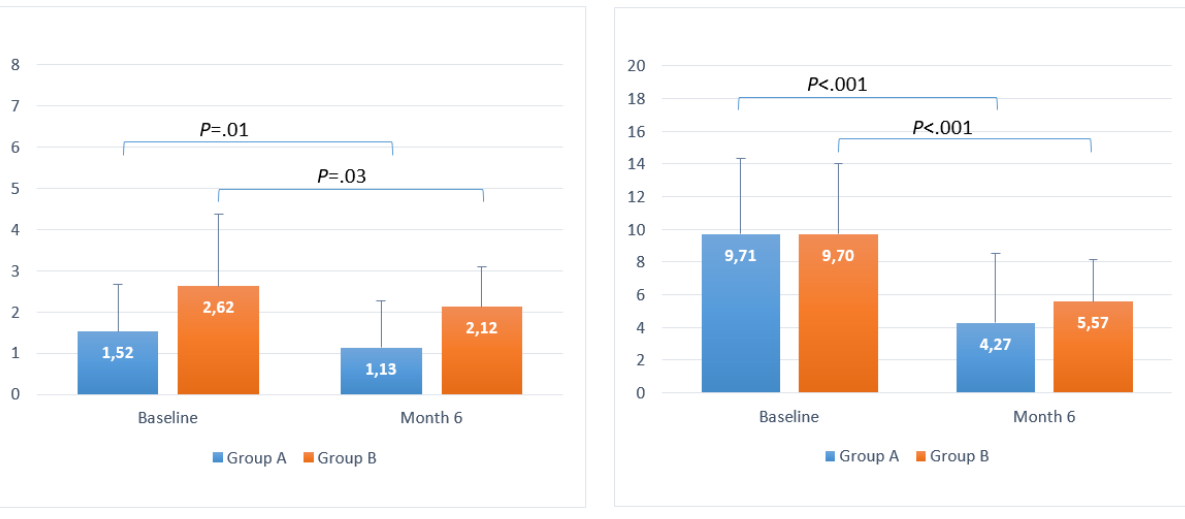
Figure 5. Timeline evolution of low blood glucose index (left) and high blood glucose index (right) for users with type 2 diabetes